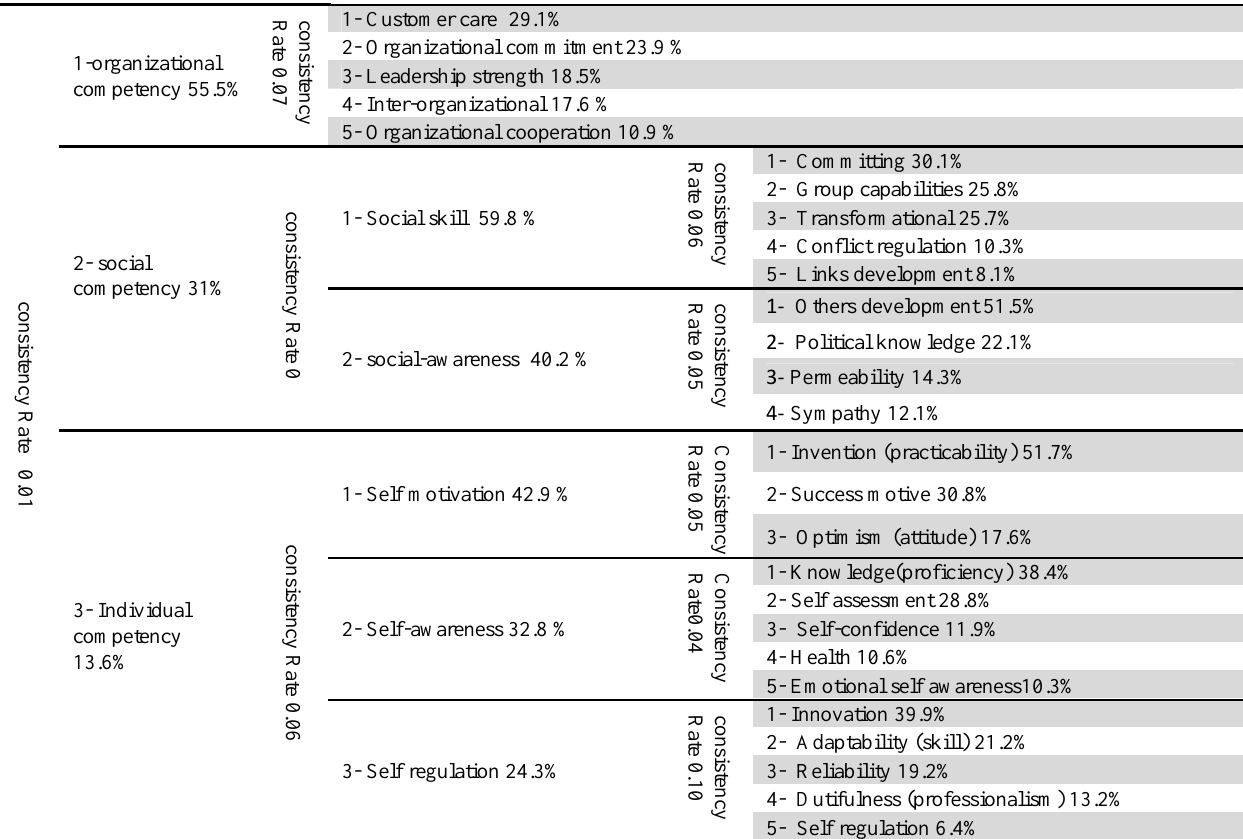
1- Customer care 29.1% c